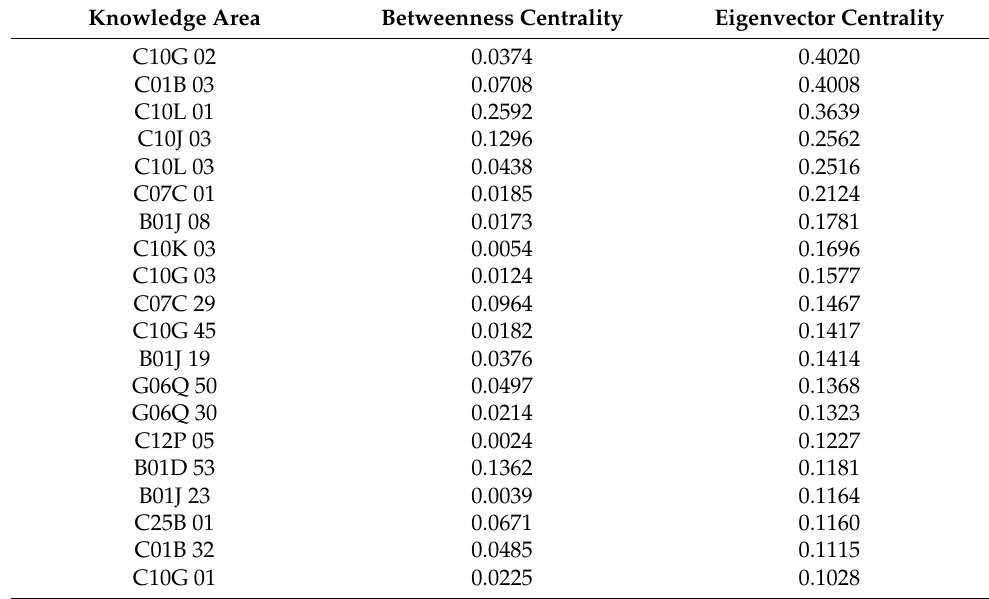
Table 3. Centrality values for the key knowledge areas (sorted by eigenvector centrality). (Note: The description of IPCs from Table 3, which are not listed in Appendix A.1, can be found in Appendix